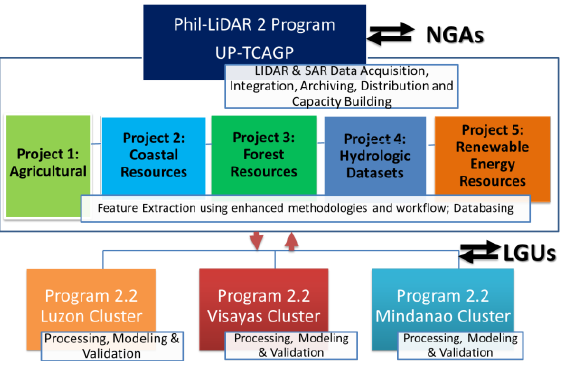
Figure 2. The Phil-LiDAR 2 Program Structure